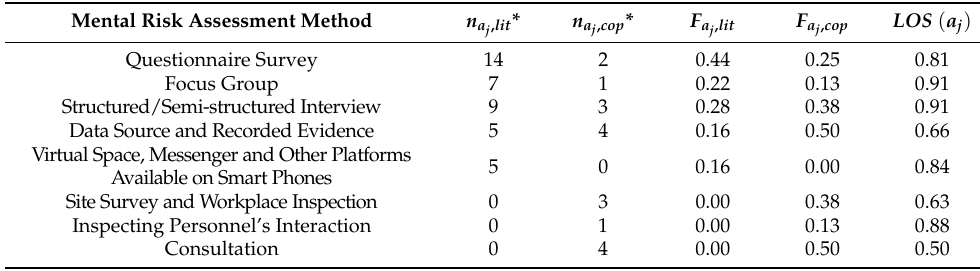
Table 7. Quantitative comparison of the selected standards and literature regarding the suggested mental risk assessment